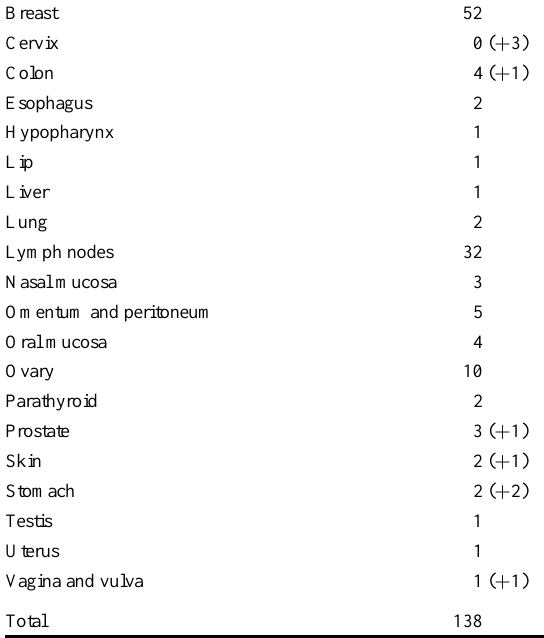
Specimens studied according to organ site. Between brackets the cases from which only standard paraffin sections (no frozen sections) have been